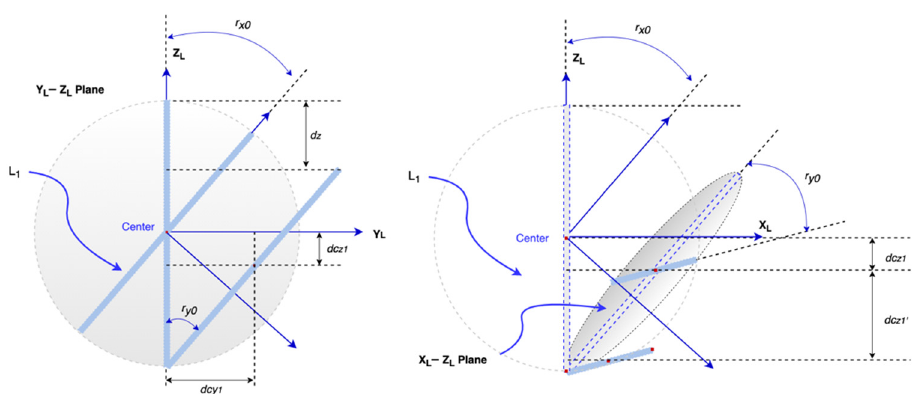
Figure 6. Shifts after two rotations.